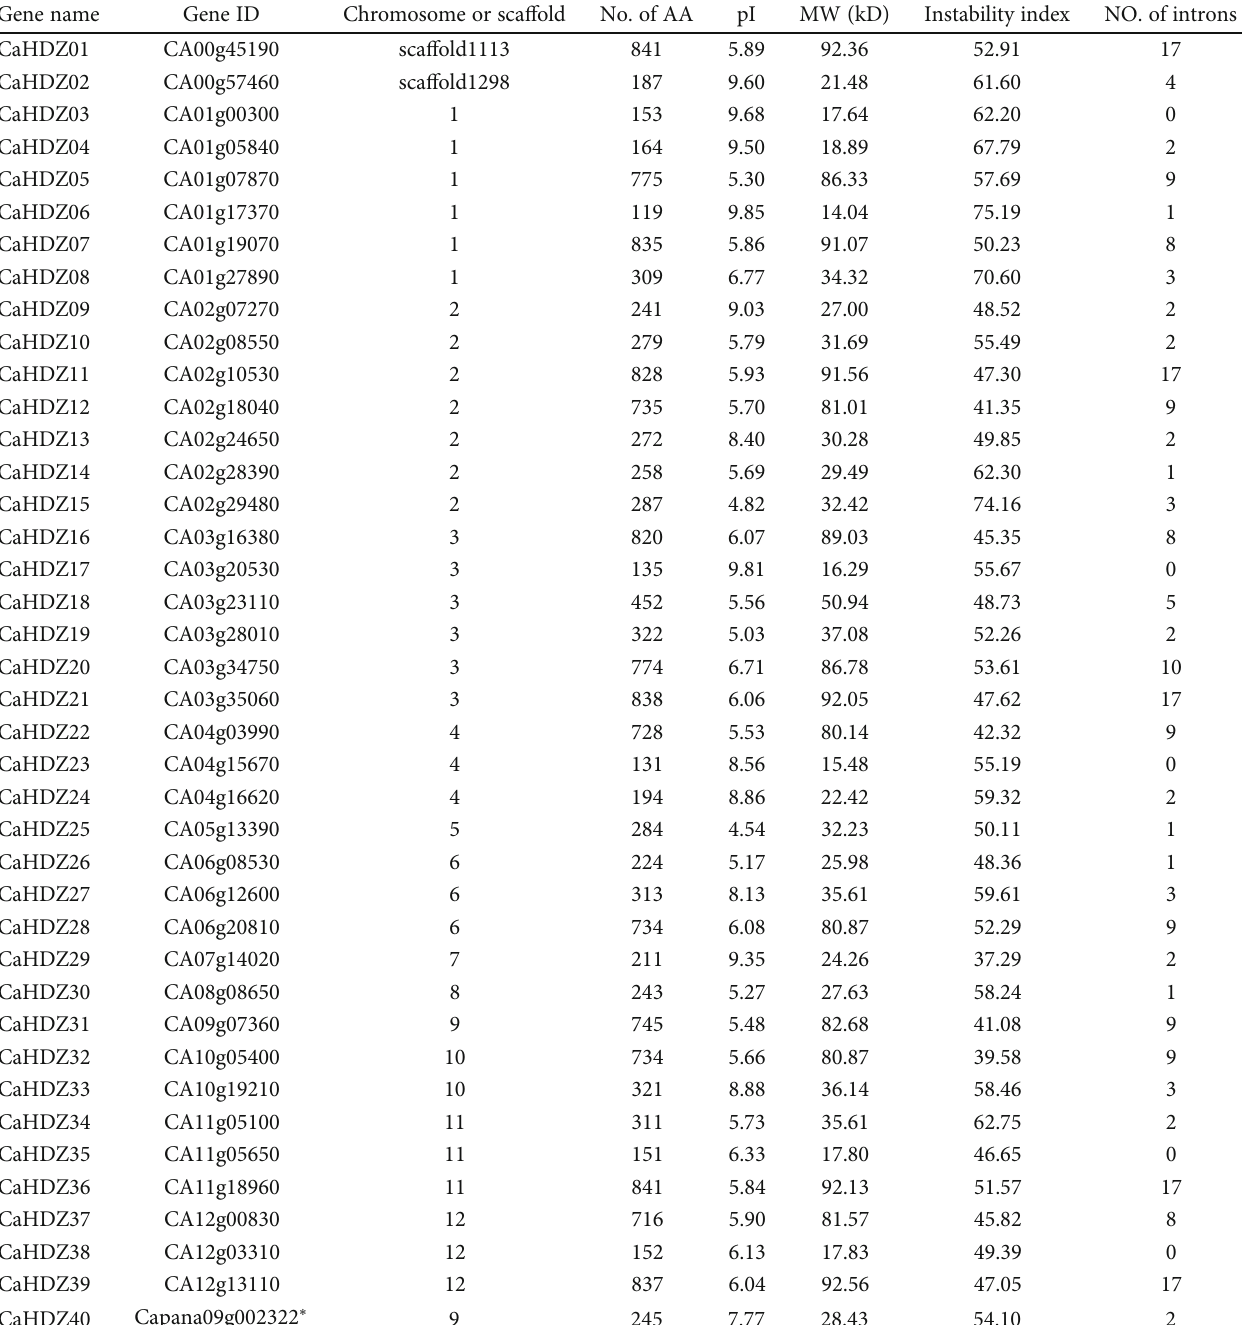
Table 1: Characteristics of CaHD-ZIP genes from Zunla-1 genome and CM334 genome. AA: amino acid; pI: the theoretical isoelectric point of proteins; Mw: the theoretical molecular weight of